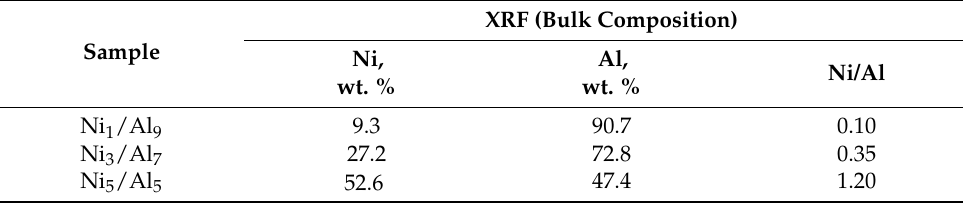
Table 3. Bulk and surface components of the NiAl 2 O 4 catalysts with various Ni/Al